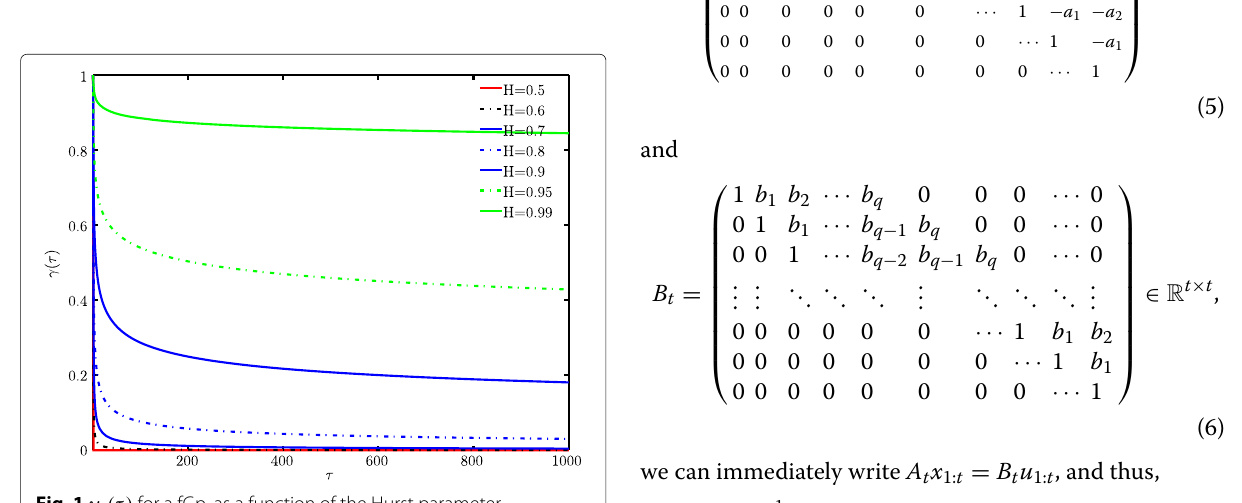
Fig. 1 γ u (τ) for a fGp, as a function of the Hurst